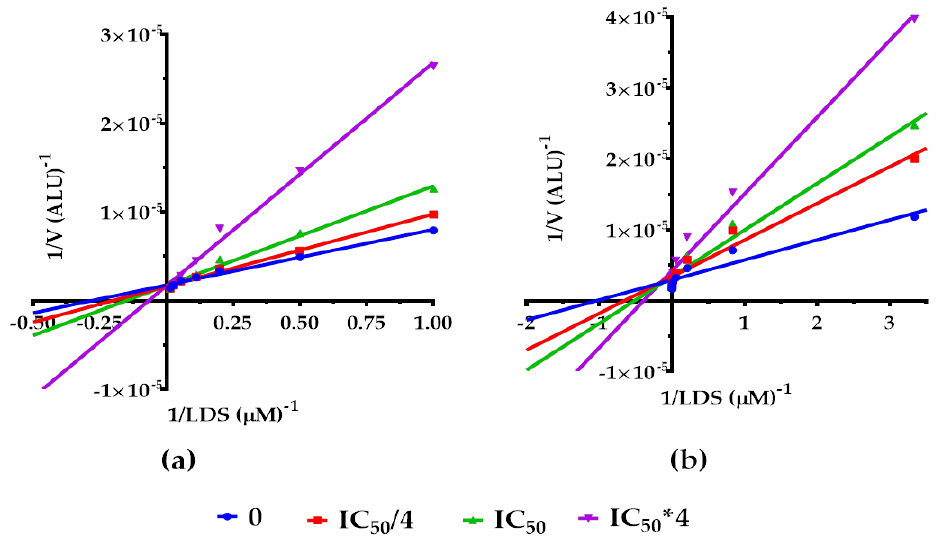
Figure 3. Michaelis–Menten kinetics of h MAO-A in the presence of KKR21 ( a ) and KKR11 ( b ). The representative Lineweaver–Burk (LWB) plots are of the inhibited h MAO-A with increasing luciferin derivative substrate (LDS) at the initial velocity (V) of producing arbitrary light units (ALU) at 37 °C. Three inhibitor concentrations were used; IC 50 /4, IC 50 , IC 50 × 4. Data points were expressed as the mean ± SEM, representing more than two experiments with n = 3 each. Table 2. The effects on enzyme maximum velocity (V max ) and the Michaelis constant (K m ) average values with increasing KKR concentration: X-intercepts of the KKR linear regressions represent the K m value changes; and the Y-intercepts of the KKR linear regressions (minimum and maximum average means shown) represent the V max value changes.